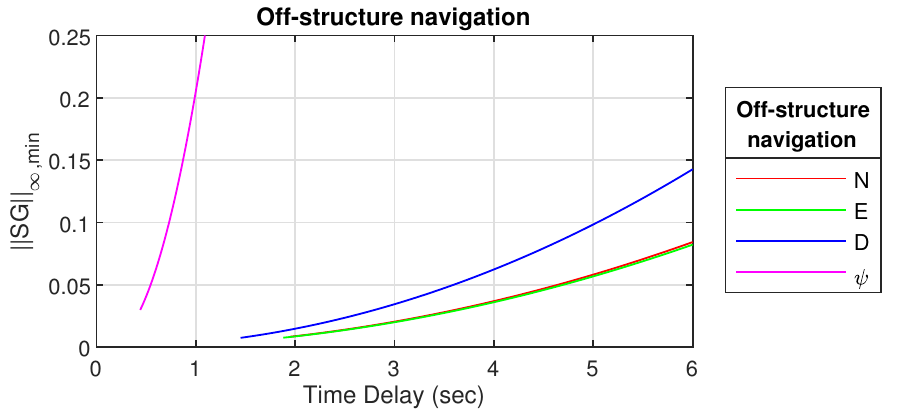
Figure 18. (cid:107) SG (cid:107) ∞ , min for off-structure